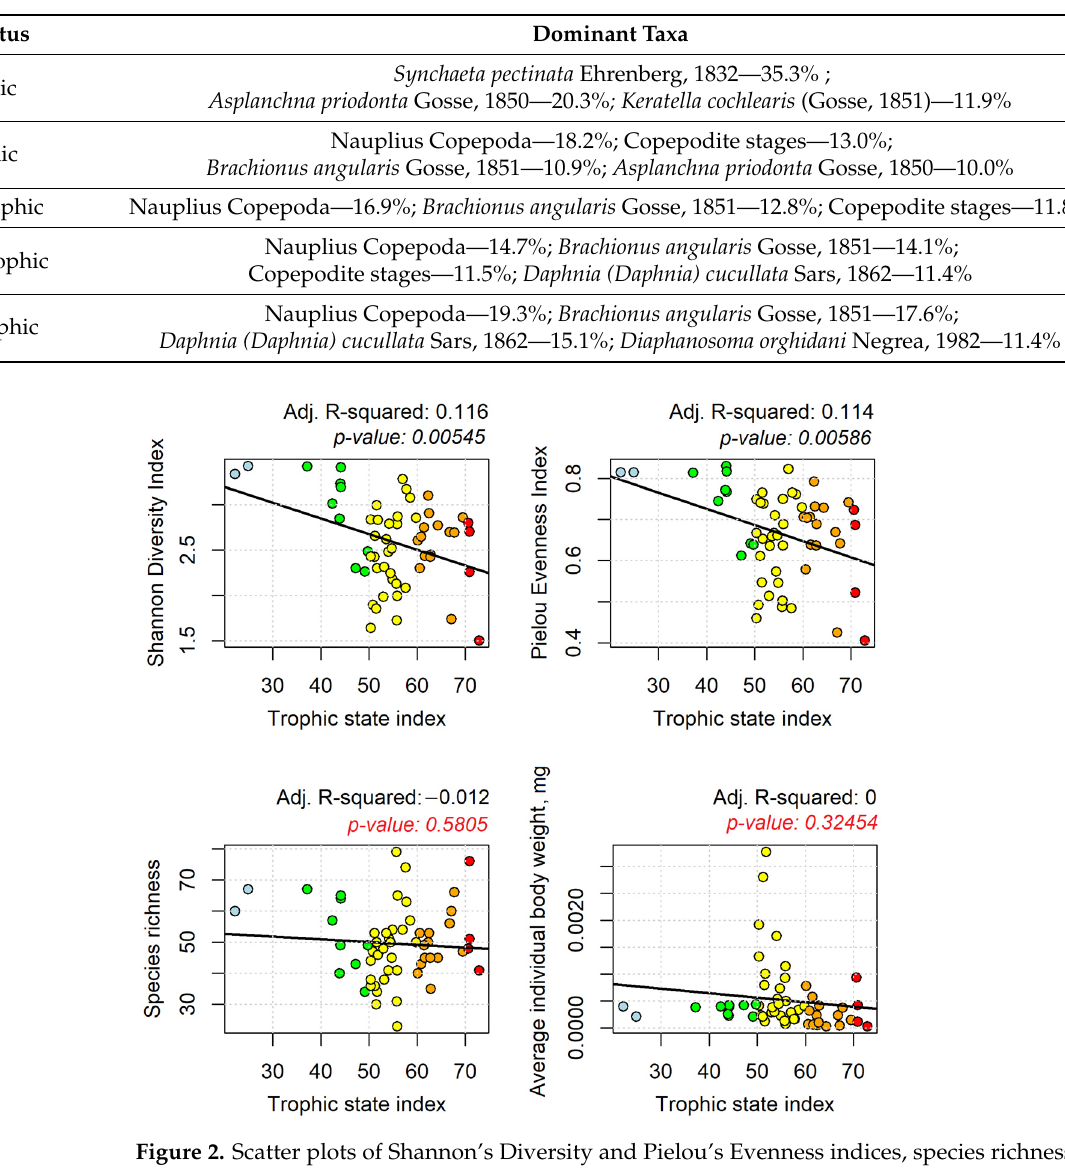
Table 3. Dominant taxa of zooplankton in different trophic conditions.